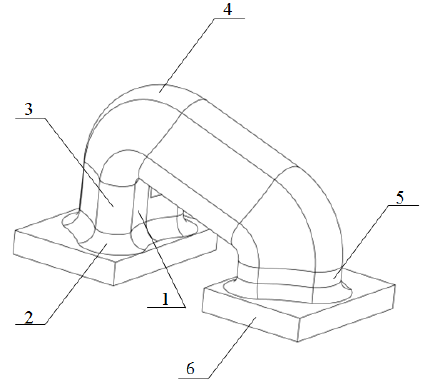
Figure 17. Unit for fixing the wagon: 1—hook guide; 2—radial tide; 3—cylindrical part; 4—prismatic part; 5—technological strengthening; 6—bearing part.